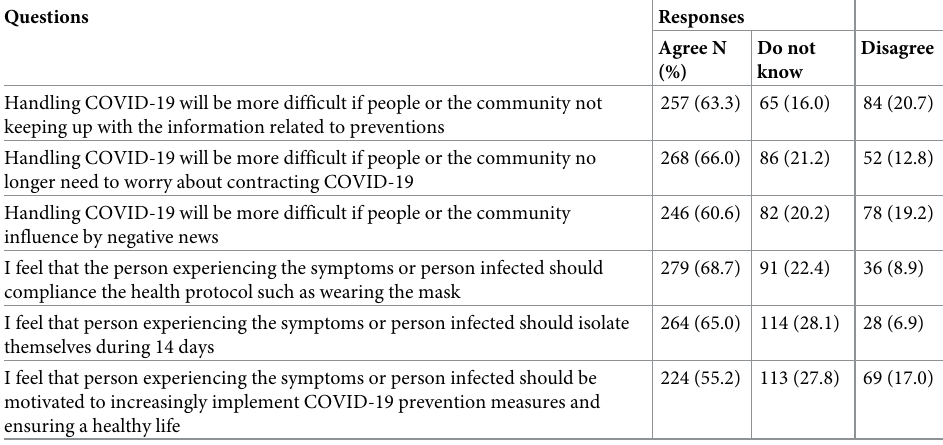
Table 3. Response to attitude questions among preparatory school students at Mizan-Aman town, 2021 (n = 406).